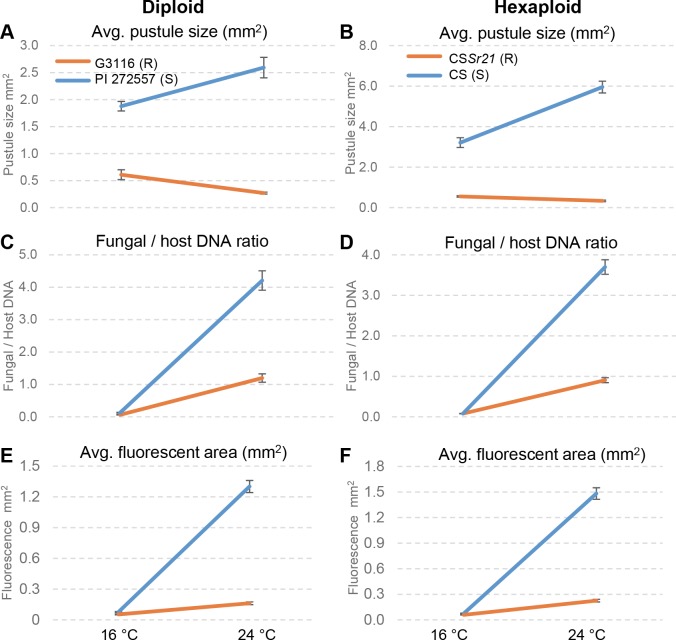
Pgt race BCCBC growth at 16°C and 24°C in different genotypes.(A, C, E) Diploid wheat. Sr21 resistant genotype G3116 (orange) and susceptible genotype PI 272557 (blue). (B, D, E) Hexaploid wheat. Sr21 resistant genotype CSSr21 (R) (orange) and susceptible genotype CS (S) (blue). (A, B) Interaction graphs for average pustule size at 14 dpi n = 6). (C, D) Interaction graphs for Pgt DNA relative to wheat DNA at 5 dpi (n = 6). (E, F) Interaction graphs for average size of individual fungal infection areas estimated by fluorescence microscopy at 5 dpi (n = 6). Lack of parallelism between lines in all graphs reflects significant interactions (P<0.0001, S6 Table).